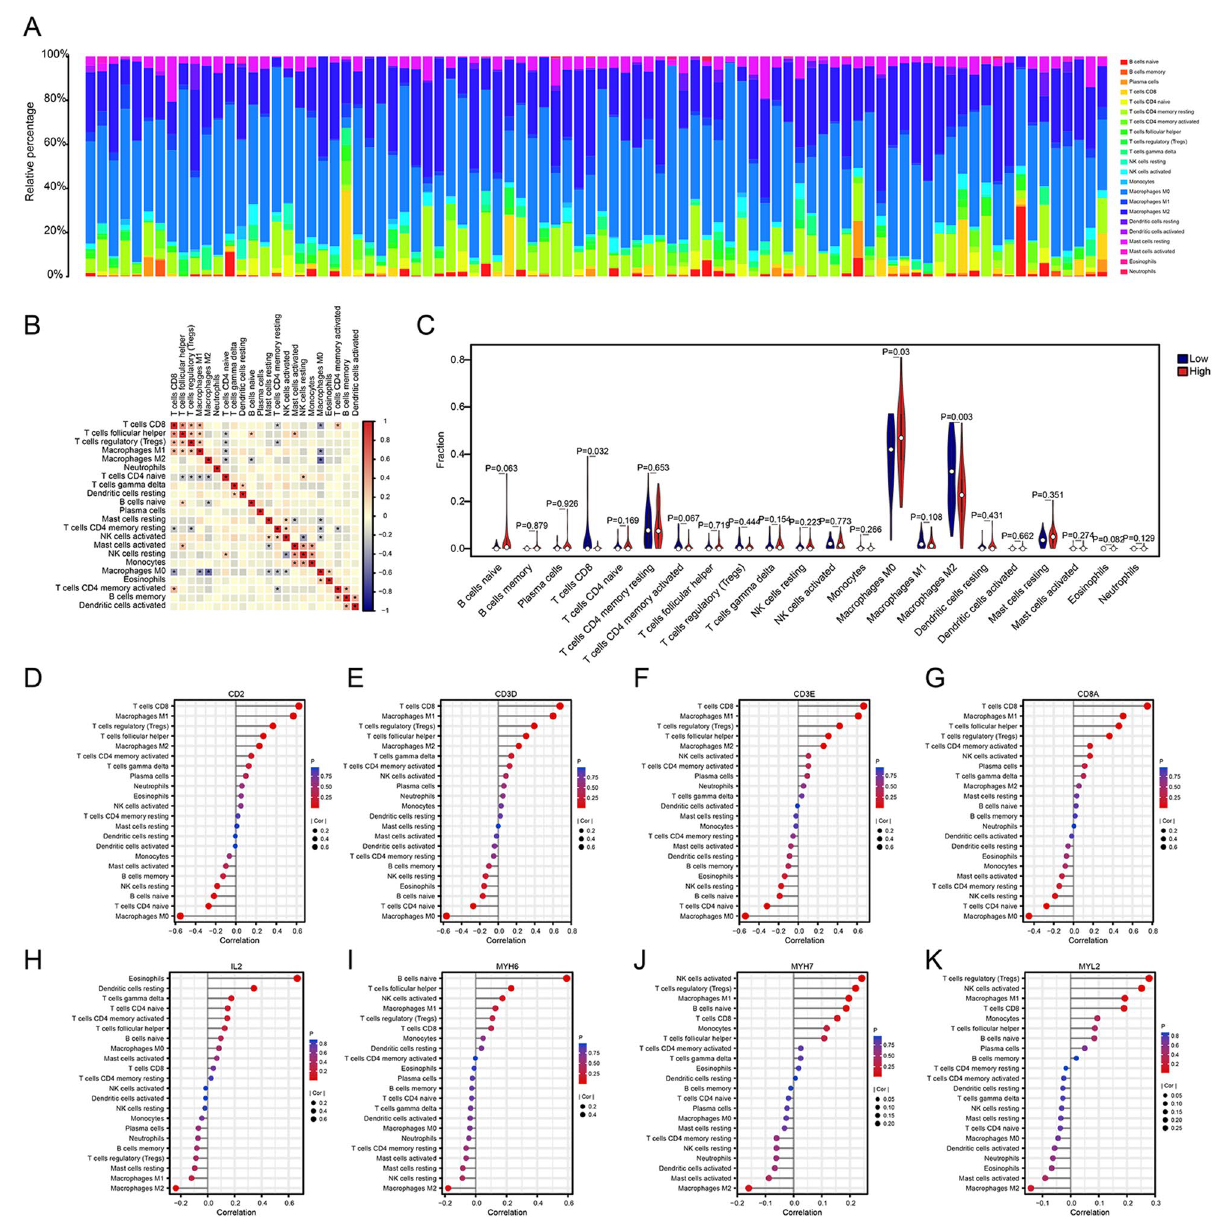
Figure 10. Risk assessment of immune cell infiltration. ( A ) Histograms of the distribution of 22 immune- infiltrating cells in the high- and low-risk subgroups. ( B ) Correlation analysis of 22 immune cells; ( C ) Differential analysis of 22 immune cells in the high- and low-risk subgroups. ( D – K ) The correlation between hub genes and 22 immune cells. *p < 0.05, **p < 0.01, ***p < 0.001, ****p < 0.0001 the TME and pulmonary metastasis in OS patients. By regulating pSTAT3 and IL-10 levels to block TAM-like polarization, dihydroxycoumarins esculetin and daphnetin play an essential role in OS metastasis in vitro and in vivo. In addition, M2 macrophages induce the depletion of T lymphocytes among other tumor-infiltrating lymphocytes, thereby reducing the maturation and secretion of pro-inflammatory cytokines. The results of this study suggested that M2-like TAMs could be a potential therapeutic target for OS. Many studies have identified a novel mechanism by which CD8 + T cells suppress tumors via the induction of ferroptosis and pyroptosis. A study 51 reported that CD8 + T cells trigger ferroptosis by suppressing the expres- sion of SLC3A2 and SLC7A11 , suggesting that the immune system might play a role in ferroptosis triggering. OS biopsies have revealed that CD8 + cytotoxic T cells are less abundant than myeloid cells, indicating that OS is poorly immunogenic. However, the results of our study indicated that CD8 + T lymphocytes are a potential factor for OS prognosis and diagnosis. This study has some limitations. First, wet lab experiments were not performed; hence, the results of bioin- formatics analysis remain to be further validated. Second, the selection of datasets and batch-to-batch variation can inevitably lead to potential biases. Finally, information on comprehensive genomic analyses with clinical